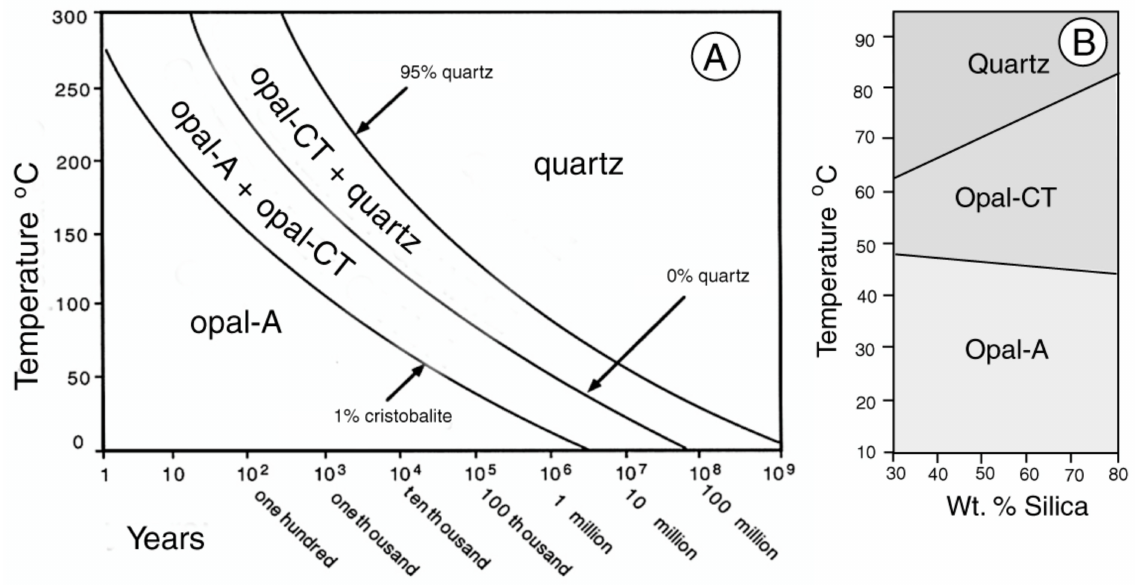
Figure 40. Generalized stability fields for opal and quartz. ( A ) Mitzutani [32] based his diagram on field observations and experimental studies, estimating ages required for silica phase transformations. ( B ) Behl’s plot [118] is based on the % of silica in biogenic sediments versus burial temperature. Both illustrations have been adapted from the original